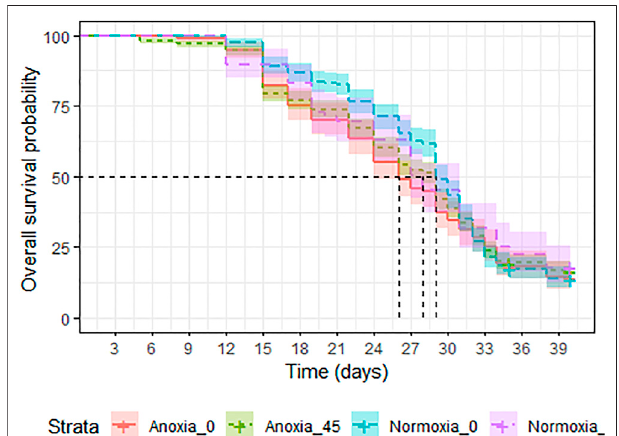
FIGURE 8 | Longevity under mating stress of adult Aedes albopictus males irradiated at 45 Gy in either anoxia (N 2 ) or normoxia (O 2 ) compared to untreated